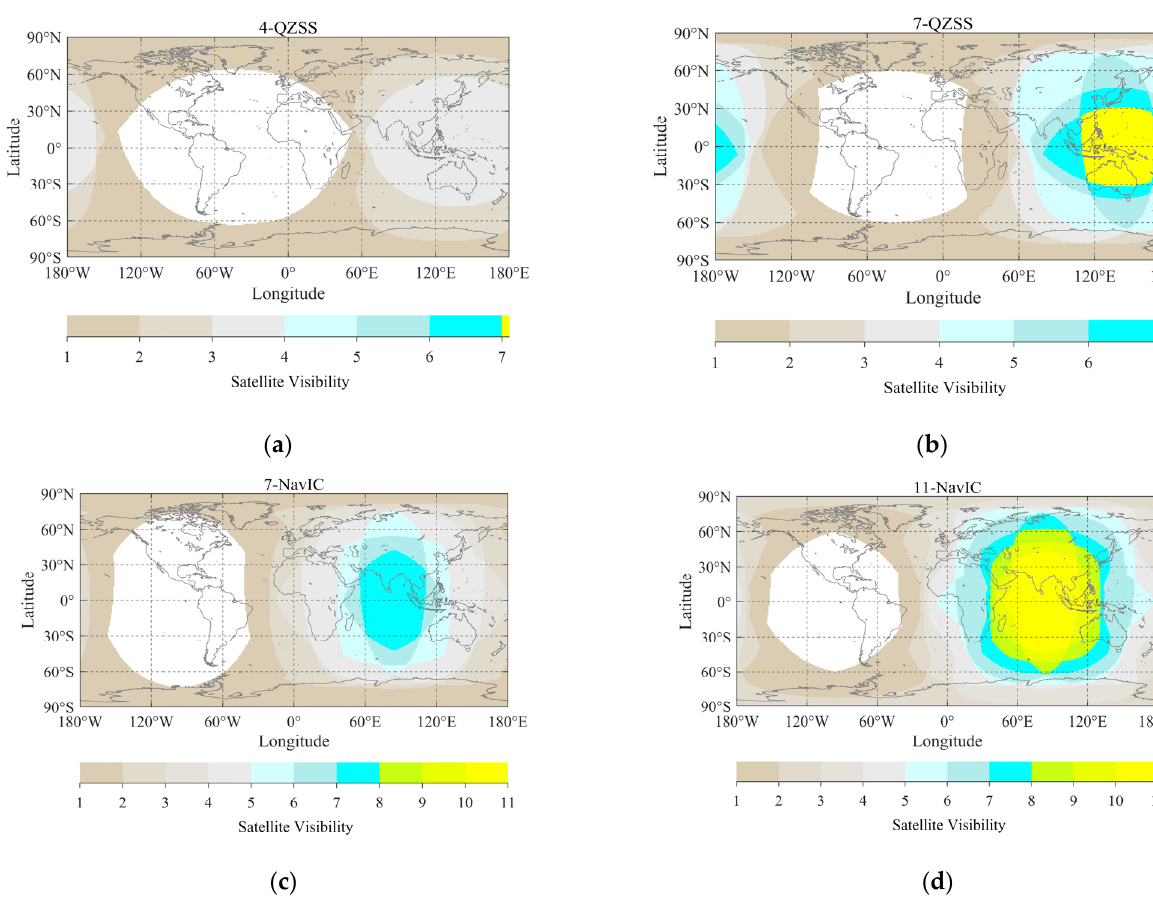
Figure 12. Satellite visibility of QZSS and NavIC: ( a ) visible satellites of 4-QZSS; ( b ) visible satellites of 7-QZSS; ( c ) visible satellites of 7-NavIC; ( d ) visible satellites of 11-NavIC. Table 7. Statistical results of satellite visibility and GDOP for 7-QZSS, 11-NavIC, and their respective combination positioning with four-GNSS-NG results.